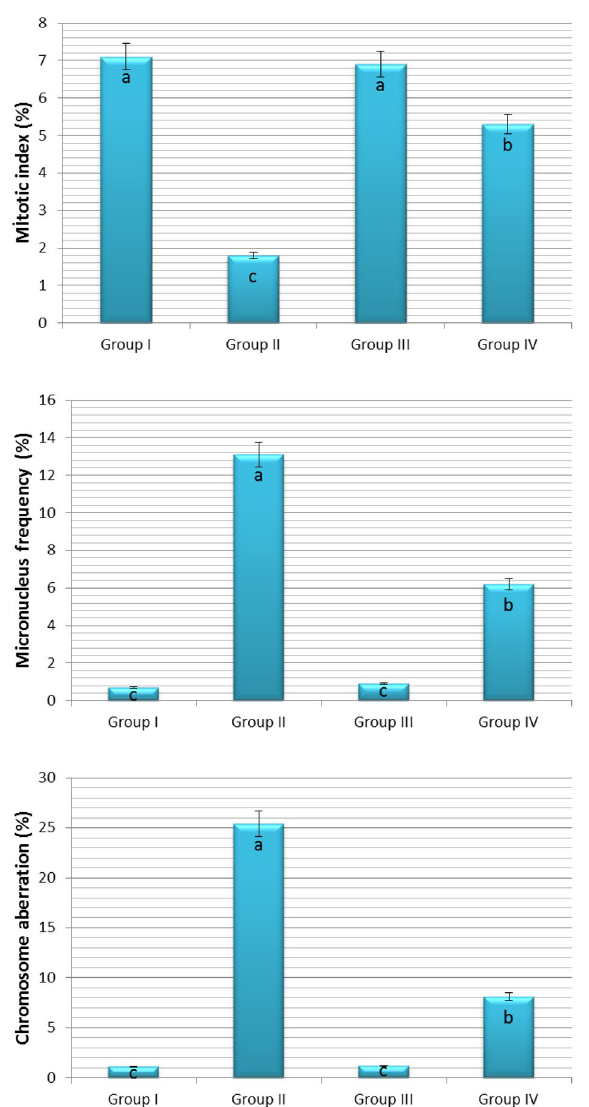
Figure 3. Effect of COR on some cytogenetic parameters of Allium cepa L. Group I (control) was treated with tap water; Group II was treated with 0.15 M NaCl; Group III was treated with 0.01 µM COR; Group IV was treated with 0.01 µM COR + 0.15 M NaCl. The error bars indicate the standard deviation (±